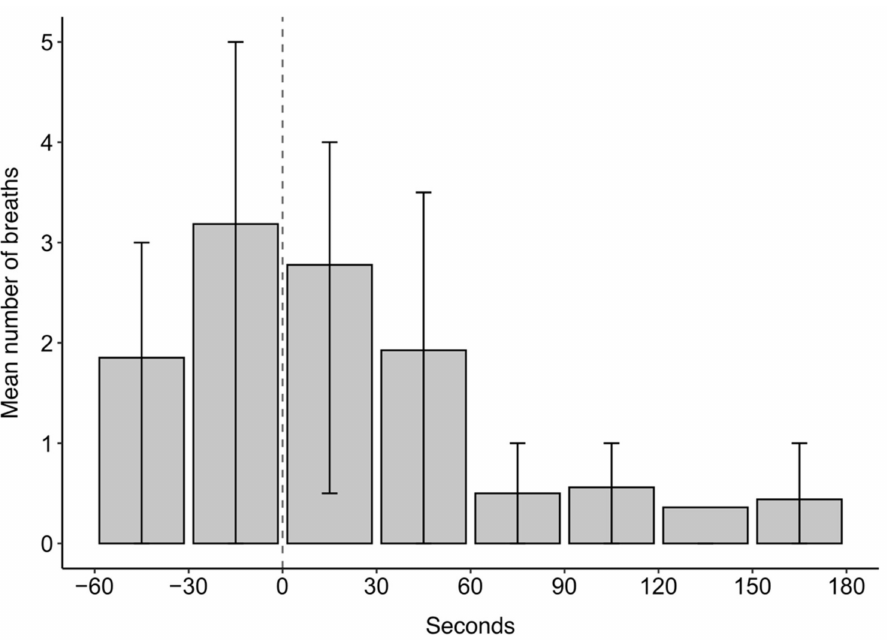
Figure 4. The mean number of breaths in 30 s intervals for 60 s before and 180 s after ketamine administration at time 0 s for 27 trials across five grey seals. Error bars represent the upper (75th percentile) and lower (25th percentile) quartile range of the